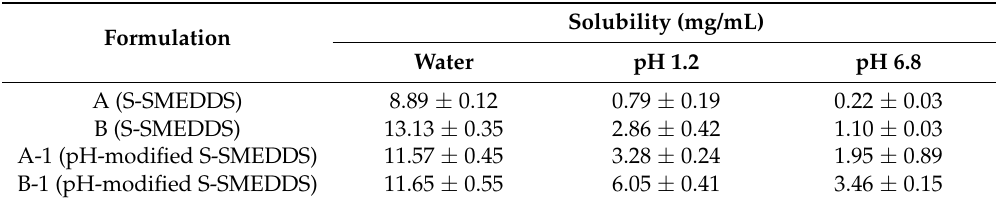
Table 5. Saturated solubility of RLH from S-SMEDDSs and pH-modified S-SMEDDSs in aqueous media. Values represent the mean ± SD ( n = 3).